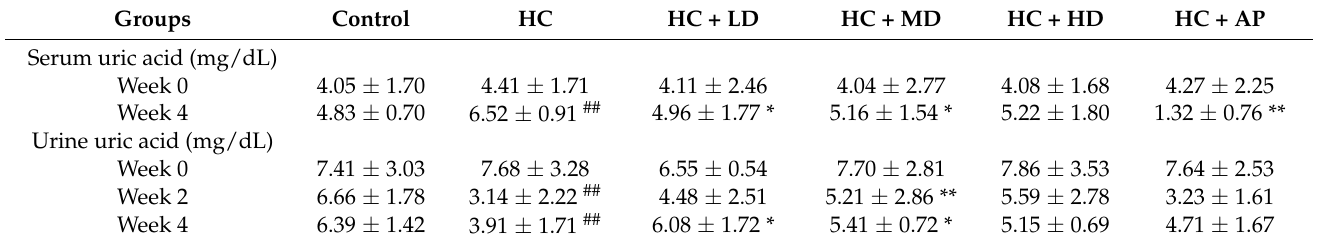
Table 4. Effects of TCI227 on serum uric acid and urine uric acid in PO-induced hyperuricemia SD rats.